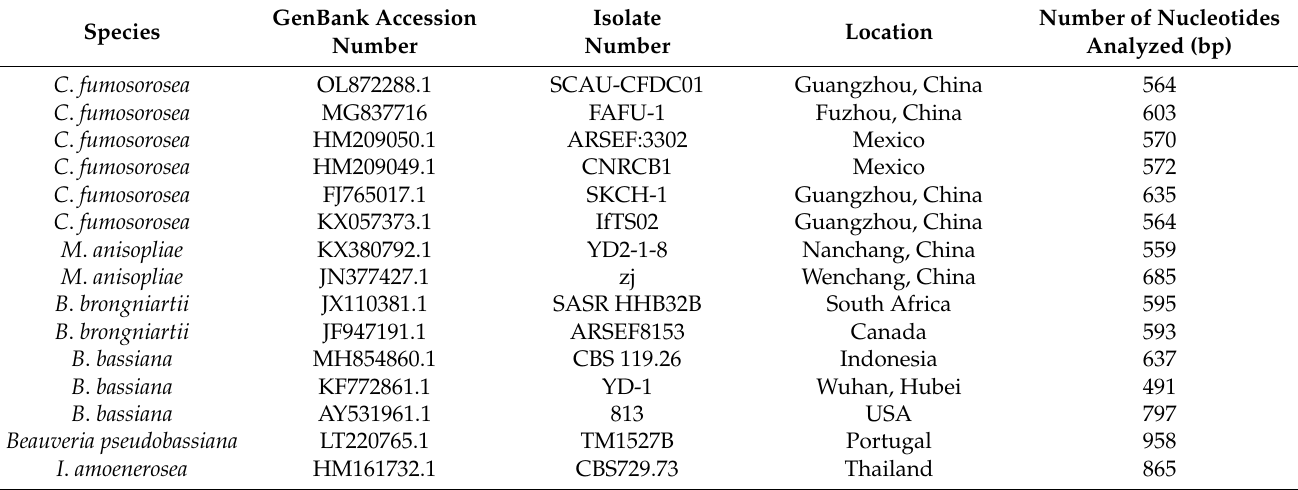
Table 1. Fungal species, GenBank accession number, isolate number, location, number of nucleotides analyzed, and of entomopathogenic